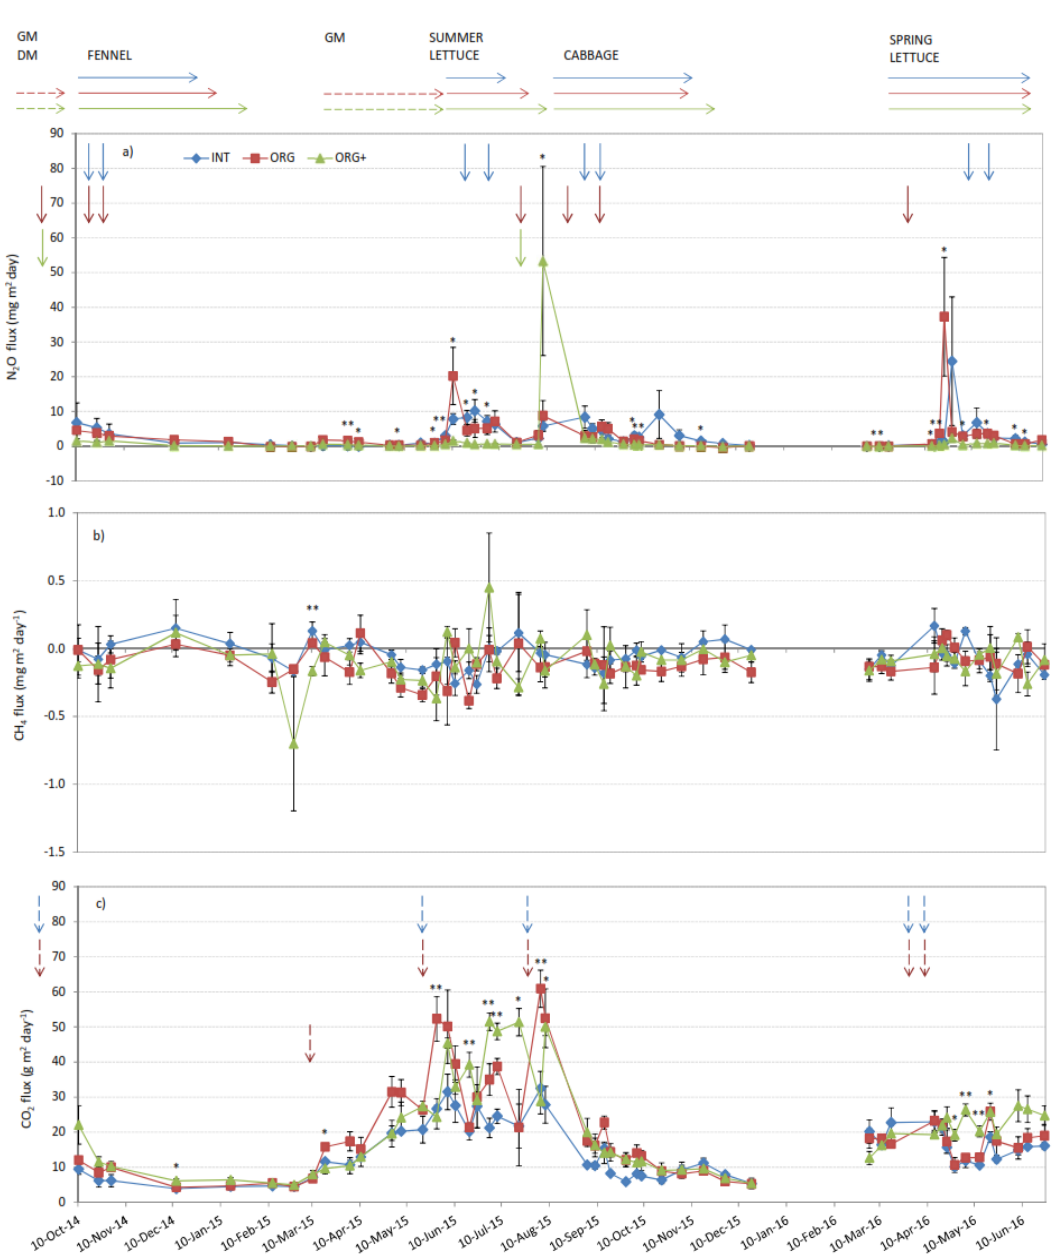
Figure 5. Daily average fluxes recorded in F1 of: ( a ) N 2 O; ( b ) CH 4 ; and ( c ) CO 2 for each treatment. Simple arrows indicate fertilization events; dashed arrows the primary tillage of each crop. On field 1 (F1) the temporal crop sequence was: Fennel, summer lettuce, cabbage, then spring lettuce. Significance was as follows: n.s. is not significant; * is significant at the p ≤ 0.05 level; ** is significant at p ≤ 0.01 level.